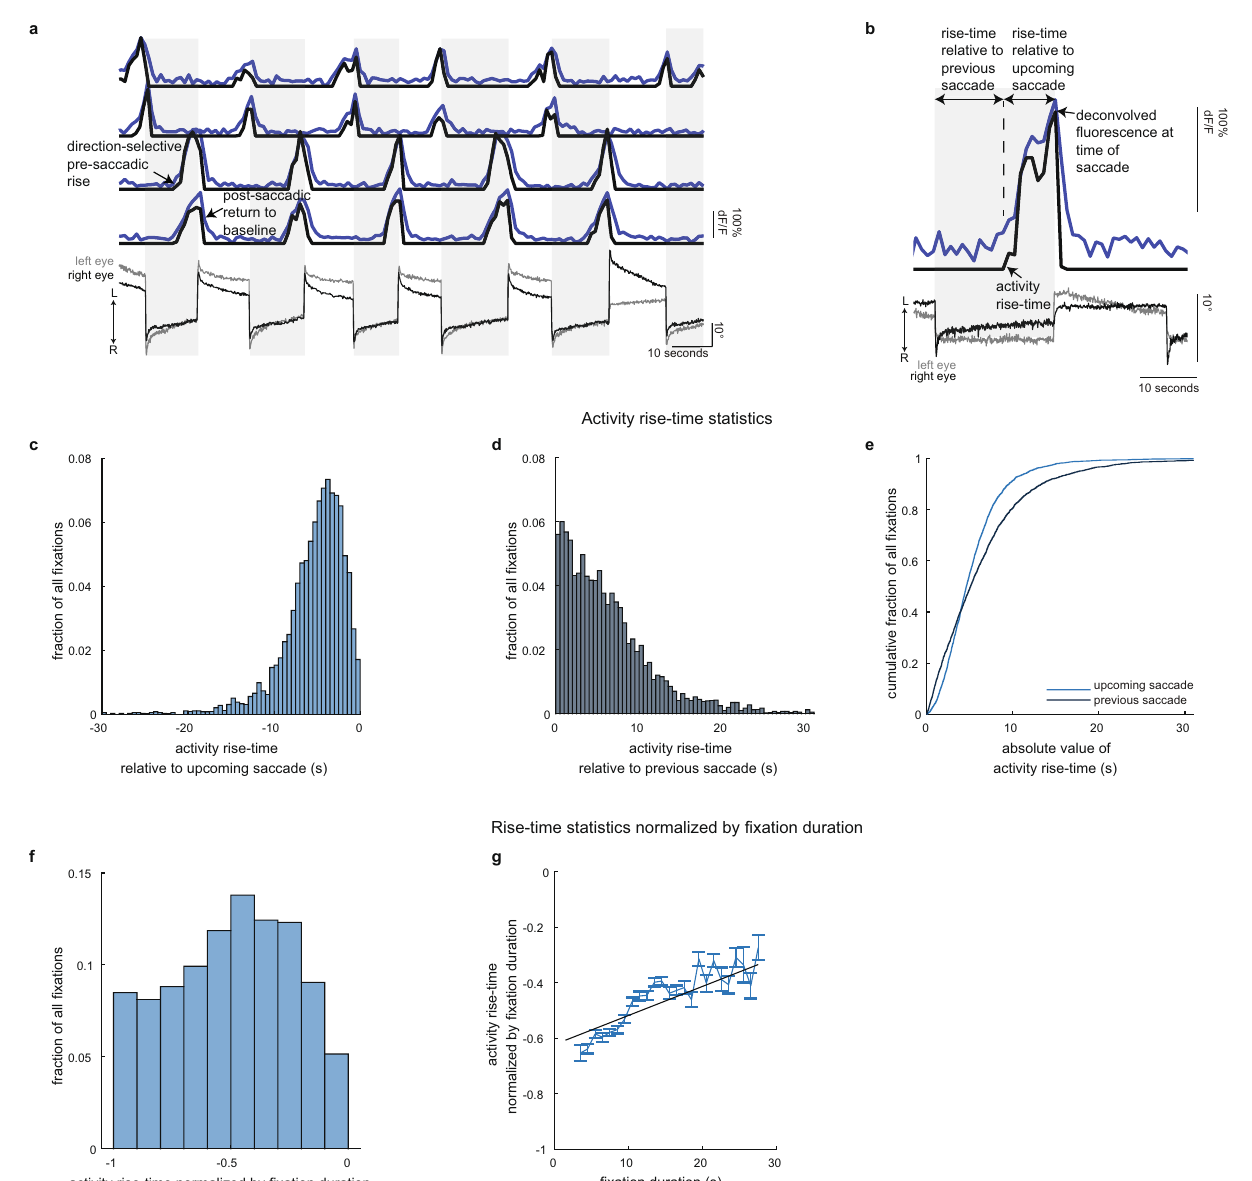
Fig. 4 Neurons whose activity anticipates saccades in a direction-selective manner. a Simultaneously recorded eye position and single-cell fl uorescence (blue) traces versus time from four cells whose activity rises before spontaneous saccades. Deconvolved fl uorescence is overlaid in black and scaled to fl uorescence (units are arbitrary). In a and b , the arrows labeled L/R indicate the direction of leftward/rightward movements. b Zoomed-in view of pre- saccadic fl uorescence (blue) and deconvolved fl uorescence activity (black) demonstrating the measurements used in subsequent analyses. c Histogram of pre-saccadic activity times of rise relative to the time of upcoming saccade. d Histogram of pre-saccadic activity times of rise relative to the time of the previous saccade. Bin size in c and d is 0.5 s. e Cumulative distribution functions of absolute value of pre-saccadic activity times of rise relative to upcoming or previous saccade. f Histogram of pre-saccadic activity times of rise, measured with respect to upcoming saccade, normalized by fi xation duration (bin size is 0.1). g Pre-saccadic activity time of rise normalized by fi xation duration as a function of fi xation duration (blue line, 1 s bins). Data shown as mean ± SEM ( n = 3,979 total fi xations from 395 cells examined over 16 fi sh). Line of best- fi t linear regression shown in black. Source data are provided in a Source data fi dynamics generally fi t under a ramp-to-threshold framework. For activity (Fig. 5d, e; at the individual cell level, this positive each cell and fi xation, we measured the rate of rise of pre-saccadic correlation was apparent for 24% of SR cells, Supplementary activity (Fig. 5b and “ Methods ” ). Across cells and fi xations, the Figs. 4e and 5f). We also examined SR activity conditioned on rate of rise of deconvolved fl uorescence varied between − 41 and whether two consecutive saccades occurred in the same or 1,890 (arbitrary units, 1st and 99th percentiles, mean = 365, n = opposite direction (Supplementary Fig. 5a) and found similar 2,715 events from 380 cells across 16 fi sh; distribution shown in trends in the distribution of the rate of rise (Supplementary Fig. 5c). This variability was positively correlated with the Fig. 5b) and the correlation between rate of rise and duration of duration of ramping activity: slowly rising activity began to ramping activity (Supplementary Fig. 5c). Furthermore, the increase above baseline on average earlier than faster rising average activity reached similar levels at the time of saccade